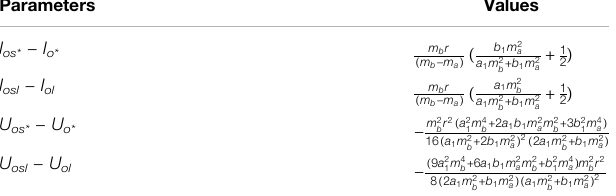
TABLE 5 | Comparison of I o and U o in Scenarios I – III. Parameters